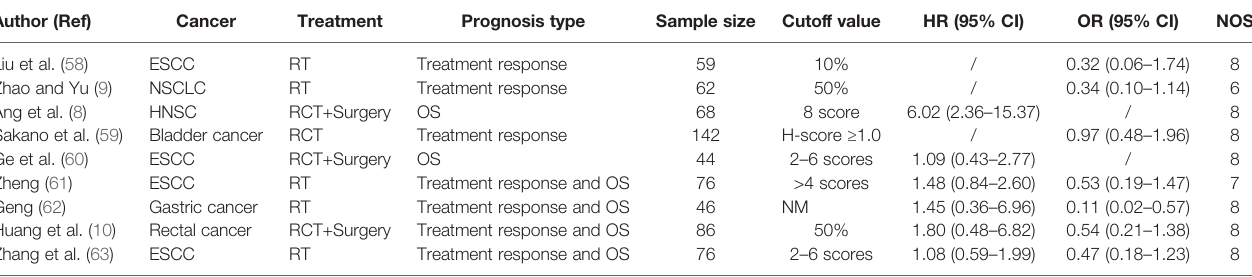
TABLE 1 | Characteristics of studies associated with XRCC1 expression and